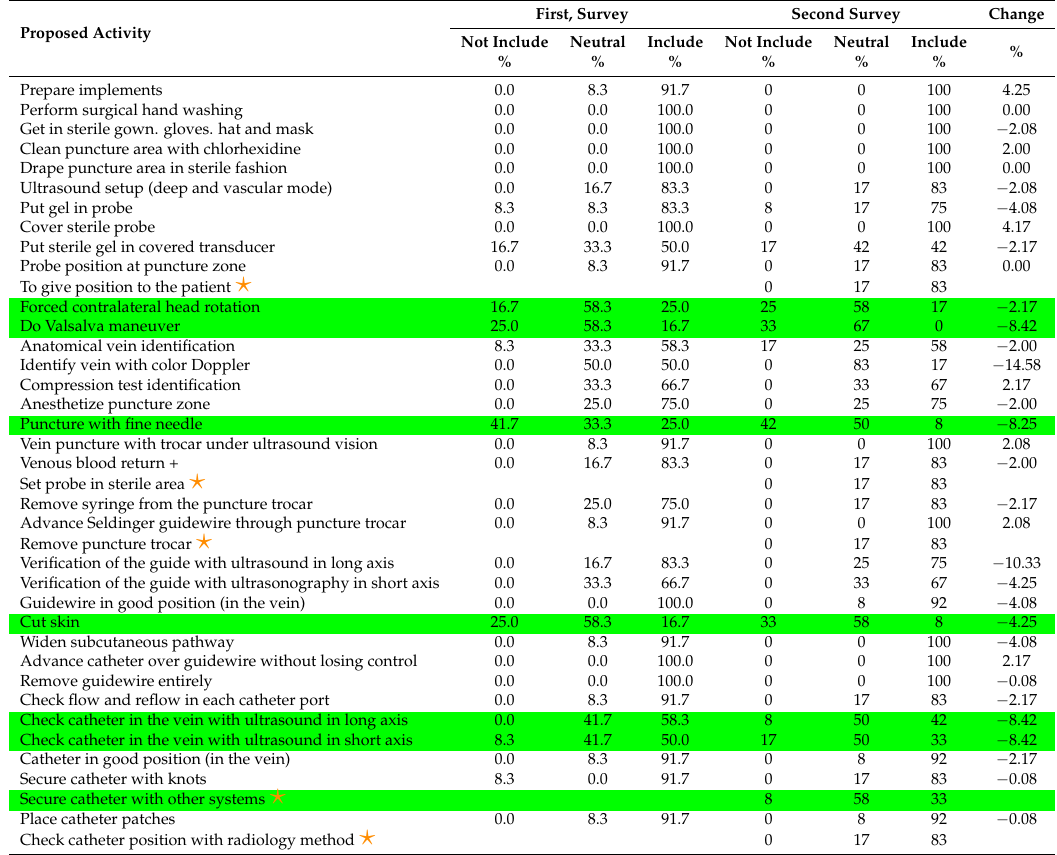
Table 2. Delphi panel results. First survey, second survey and percentage change of each response between the two rounds. Display responses of the first and second round of the Delphi panel. First, Survey Second Proposed Activity